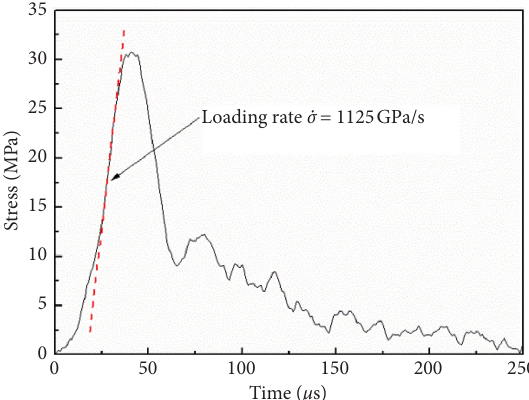
Figure 3: The loading rate for the dynamic tensile